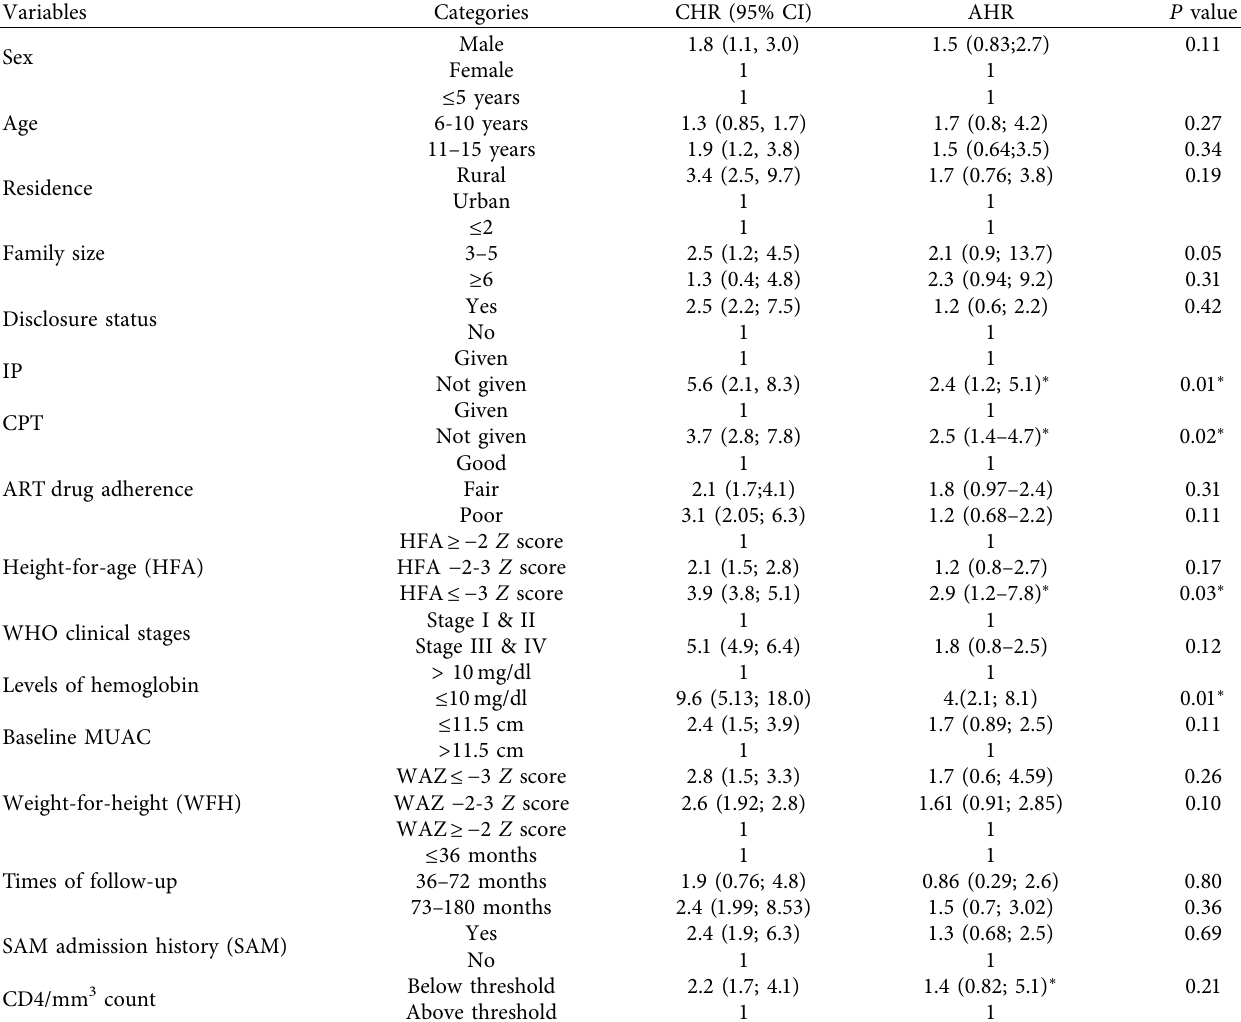
Table 5: Bivariable and multivariable Cox-proportional hazard analysis for predictors of PTB among children who received ART in a selected public health facility in Northwest Ethiopia ( N �